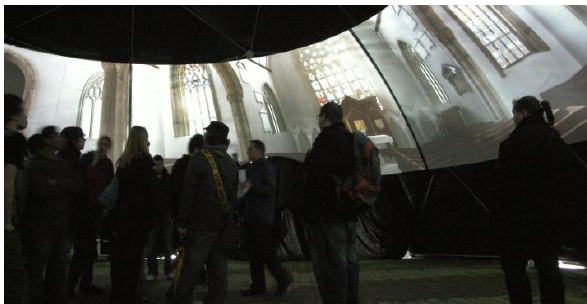
Figure 21 The interior of an immersive space (Arena360) where the audience is watching 360º film about Charles Church. Photo: D. Hotchkiss.